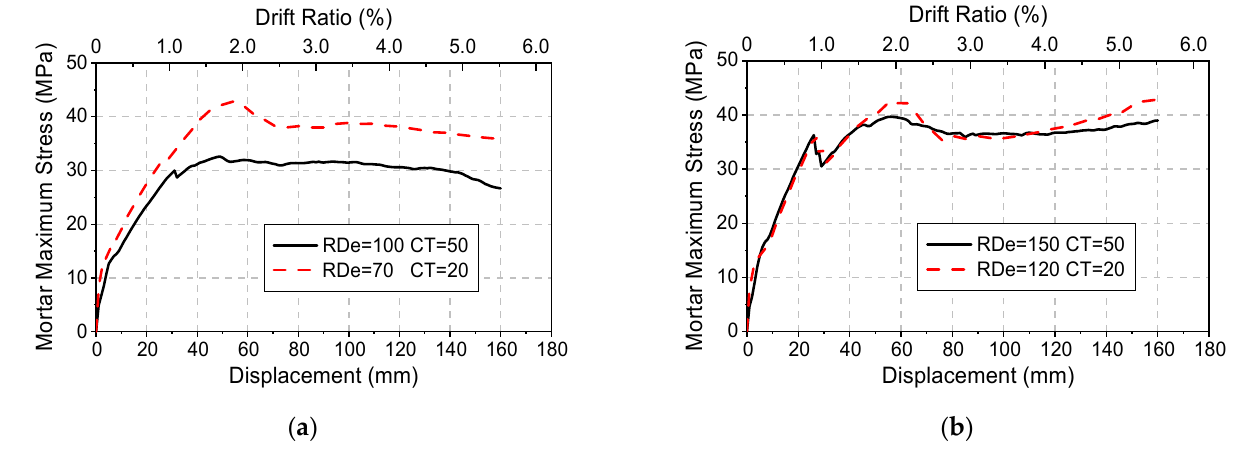
Figure 25. Maximum mortar stress of different cushion thicknesses: ( a ) shallow recess; ( b ) deep recess. The cushion acts as the medium that transfers the stress from column to